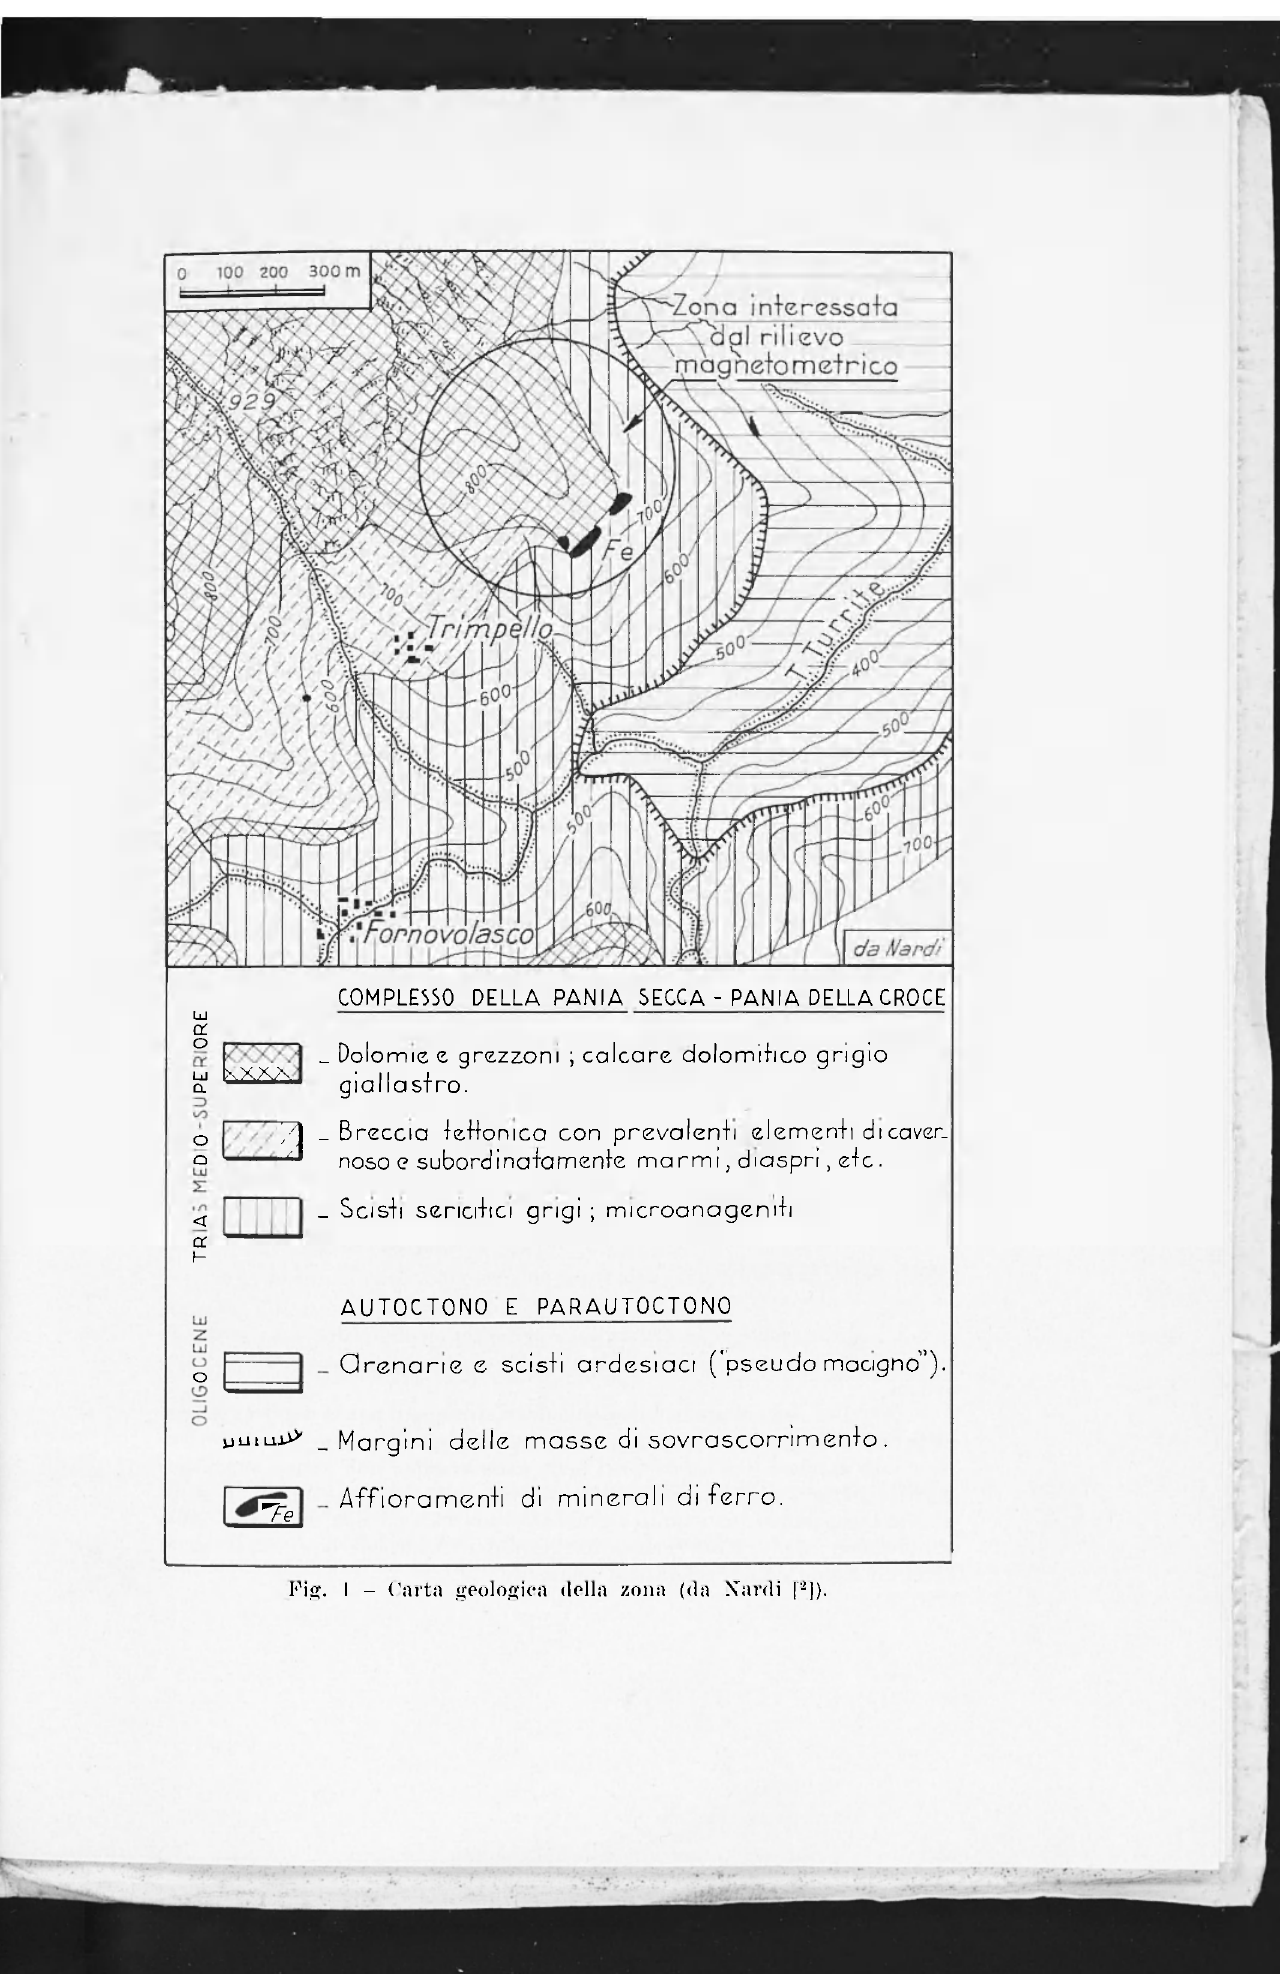
Fig. I - Carta geologica della zona (da Nardi [ 2